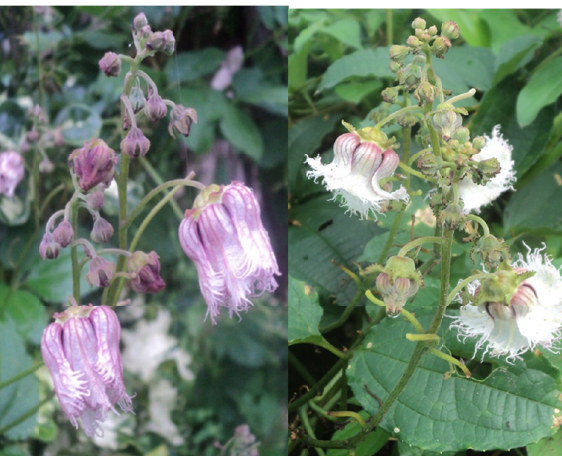
aceme of staminate flowers